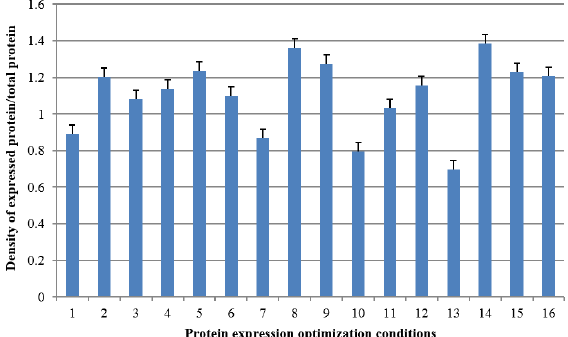
Fig. 2. Quantitative analysis of protein expression optimization conditions : 1-16= Different trials used in M16 orthogonal experimental design.